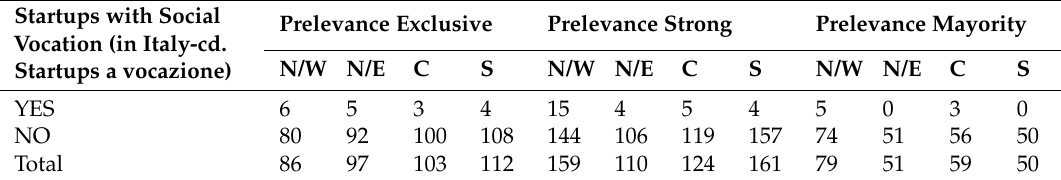
Table 17. Type of Italian woman startups (WSU) with or without social vocation to geographical macroarea. Startups with Social Vocation (in